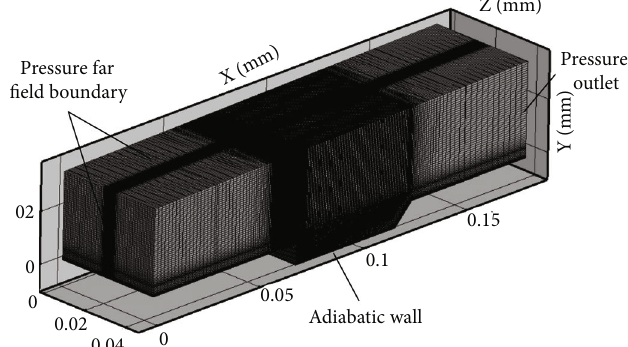
Figure 2: Computational zones and